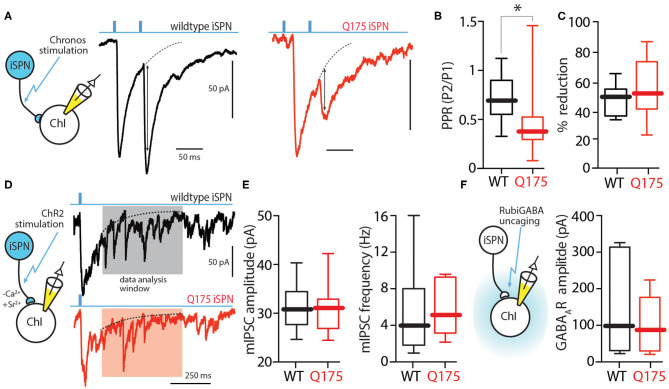
Presynaptic locus of change resulting in enhanced iSPN-ChI GABA signaling. (A) Sample traces showing two 0.5 ms long 470 nm light pulses 50 ms apart (20 Hz) and the resulting inward currents in WT (black) and zQ175+/− (red) ChIs. (B) Box plots showing medians of the PPR in ChIs from WT and zQ175+/− mice. PPR is defined as peak amplitude of 2nd eIPSC/peak amplitude of the 1st eIPSC. (C) Application of the D2 receptor agonist quinpirole (1 μM) causes a decrease in eIPSC amplitude at the iSPN-ChI synapse in both WT and zQ175+/− mice. (D) Strontium-evoked asynchronous GABA release amplitude is unchanged in zQ175+/− mice. Replacement of calcium with strontium results in asynchronous neurotransmitter release. Sample traces of optogenetically evoked events in ChIs taken from WT and zQ175+/− mice. Events smaller than 5x RMS of the noise were eliminated from analysis. (E) Box plots showing median amplitude and frequency of evoked asynchronous IPSCs for WT and zQ175+/− mice. (F) GABA current elicited at ChIs from RuBiGABA uncaging. Box plots showing medians of GABAA receptor currents following uncaging. *P < 0.05.